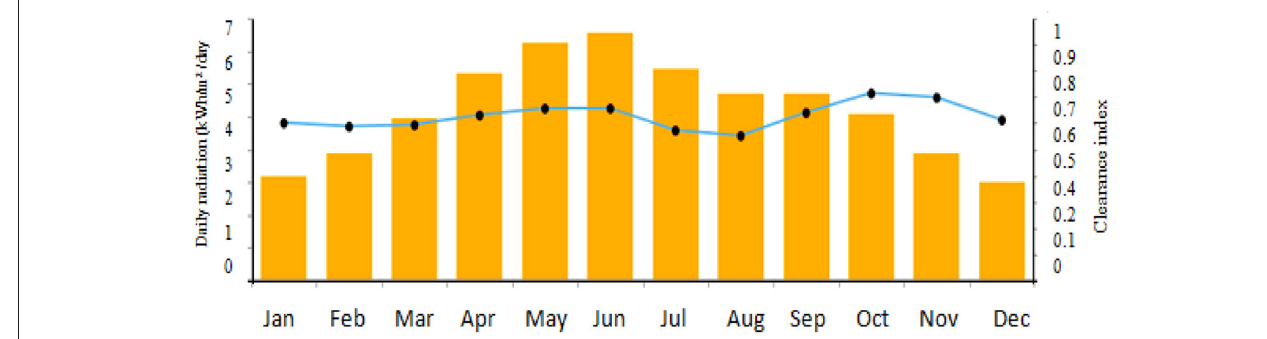
FIGURE 7 | Available solar radiations for Pakistan.